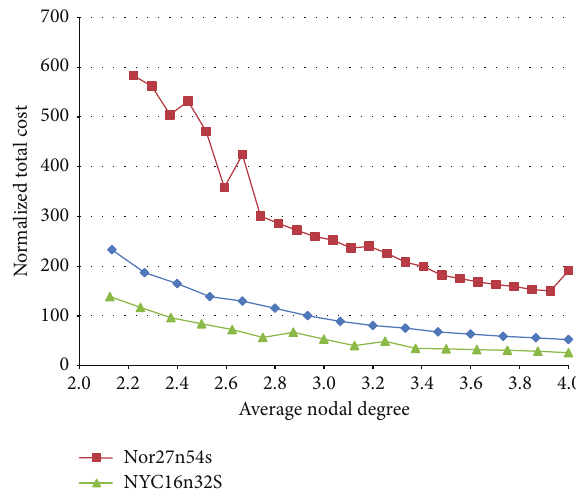
Figure 25: Normalized p -cycle restoration JCA costs for network families based on real network.